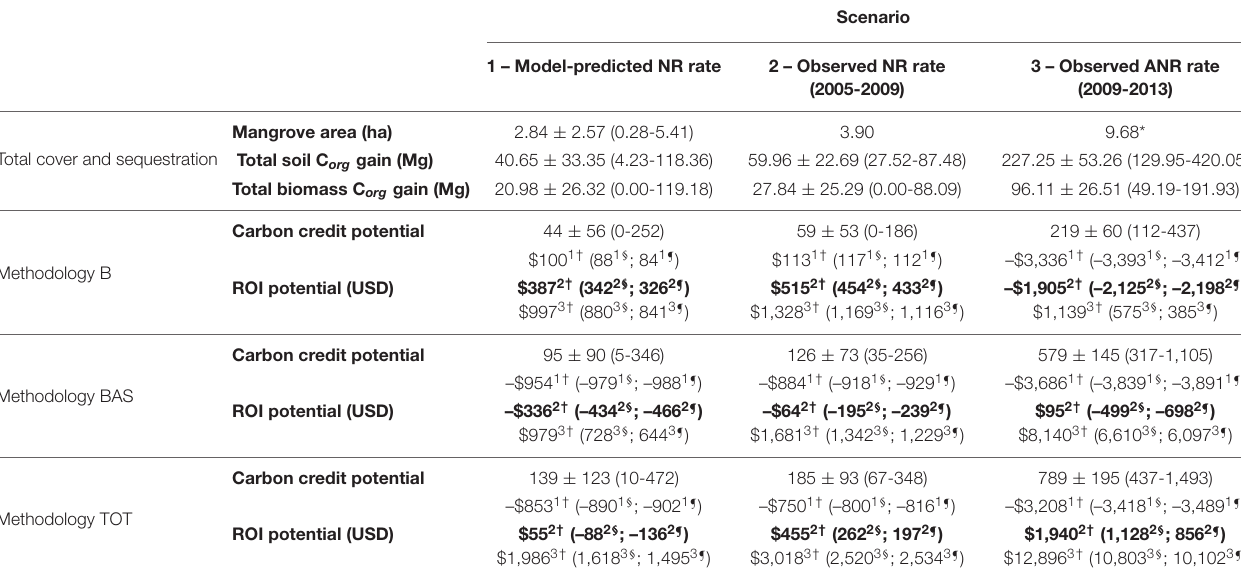
TABLE 4 | Potential mangrove carbon sequestration profiles and voluntary market carbon credit transaction potential from model-predicted and observed regeneration rate scenarios at the Leganes Katunggan, Iloilo abandoned aquaculture